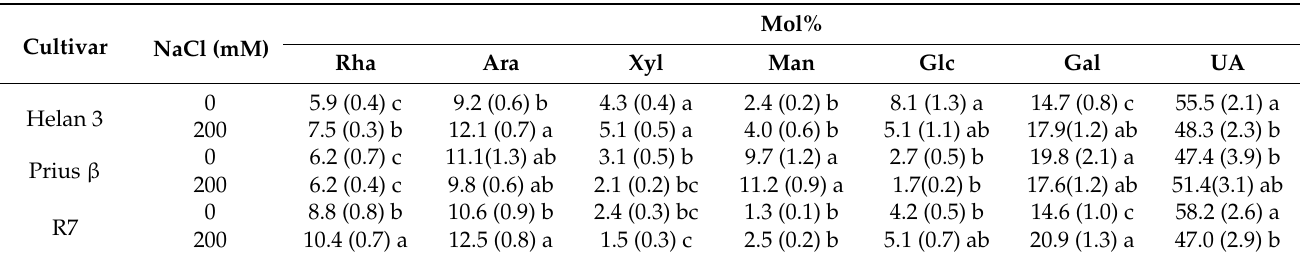
Table 1. Monosaccharide composition (mol%) of rhamnose (Rha), arabinose (Ara), xylose (Xyl), mannose (Man), glucose (Glc), galactose (Gal) and uronic acid (UA) in Helan 3, Prius β and R7 cultivars under salinity stress. Data are mean ± S.E. ( n = 6).